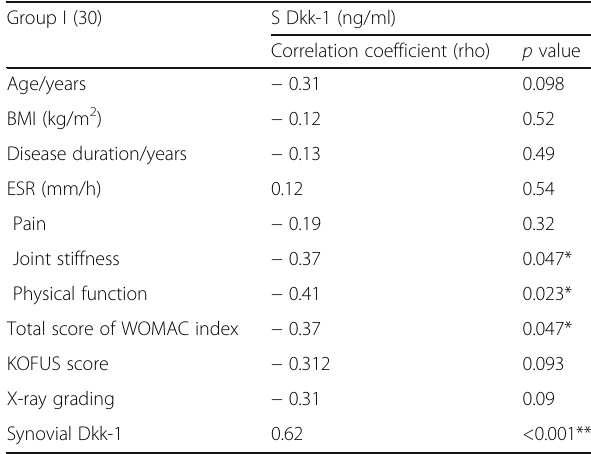
Table 3 Correlations of mean serum Dkk-1 level with mean demographic, clinical, and laboratory parameters in osteoarthritis group; negative correlations were observed between serum Dkk1 and pain score, joint stiffness and physical function, and positive correlation with synovial